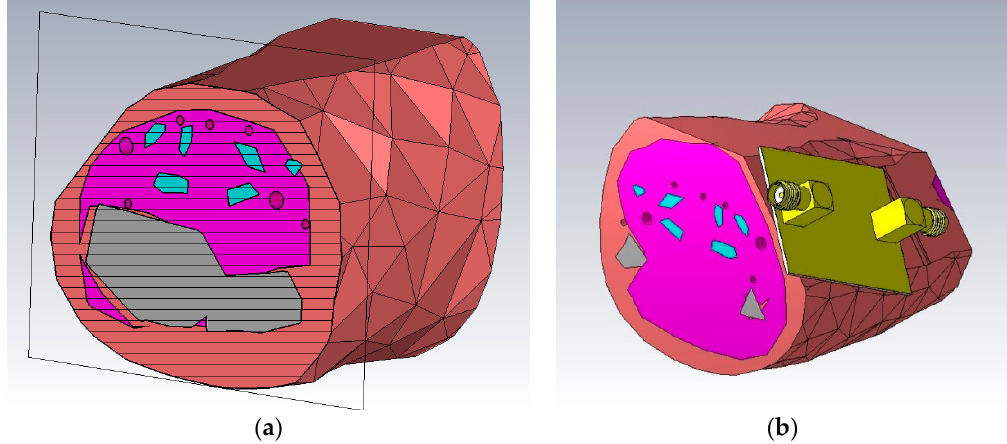
Figure 2. CST Microwave Studio models of the forearm. The salmon colored material is simulated as skin, the pink colored material represents muscles, grey is used for bones, red for arteries and veins and finally cyan for tendons. ( a ) Cross section of the model; ( b ) Resonator placed on the